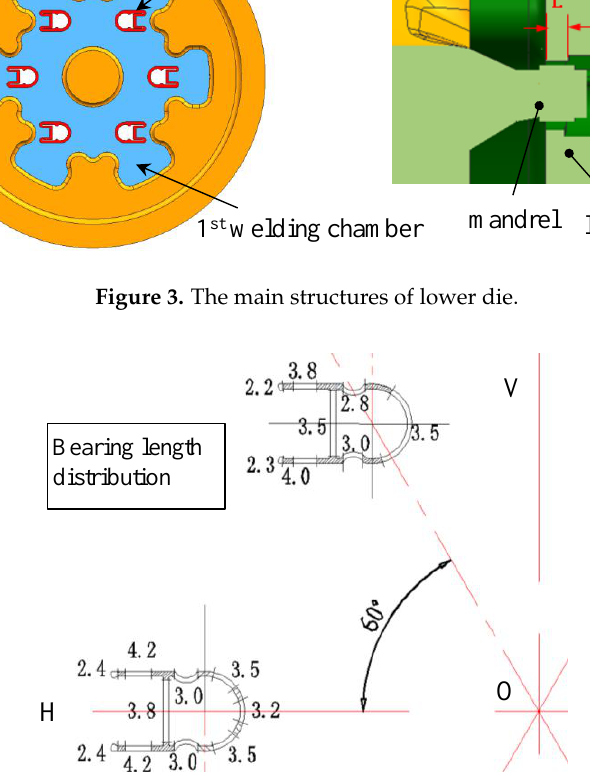
Figure 4. The non-uniform bearing length distribution of lower die.